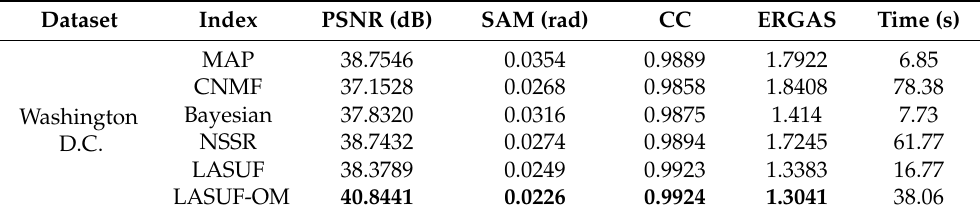
Table 2. Comparison of average statistical indexes of different methods of data Washington D.C.